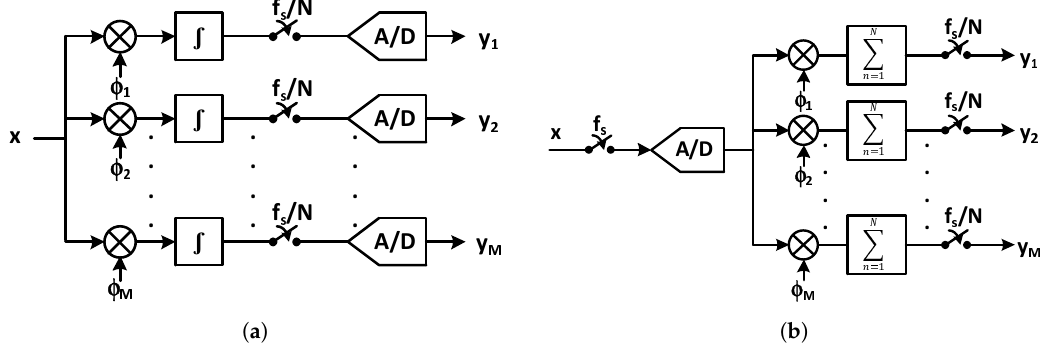
Figure 14. Block diagram of compressive sensing (CS) core of ( a ) an analog implantation ( b ) a digital